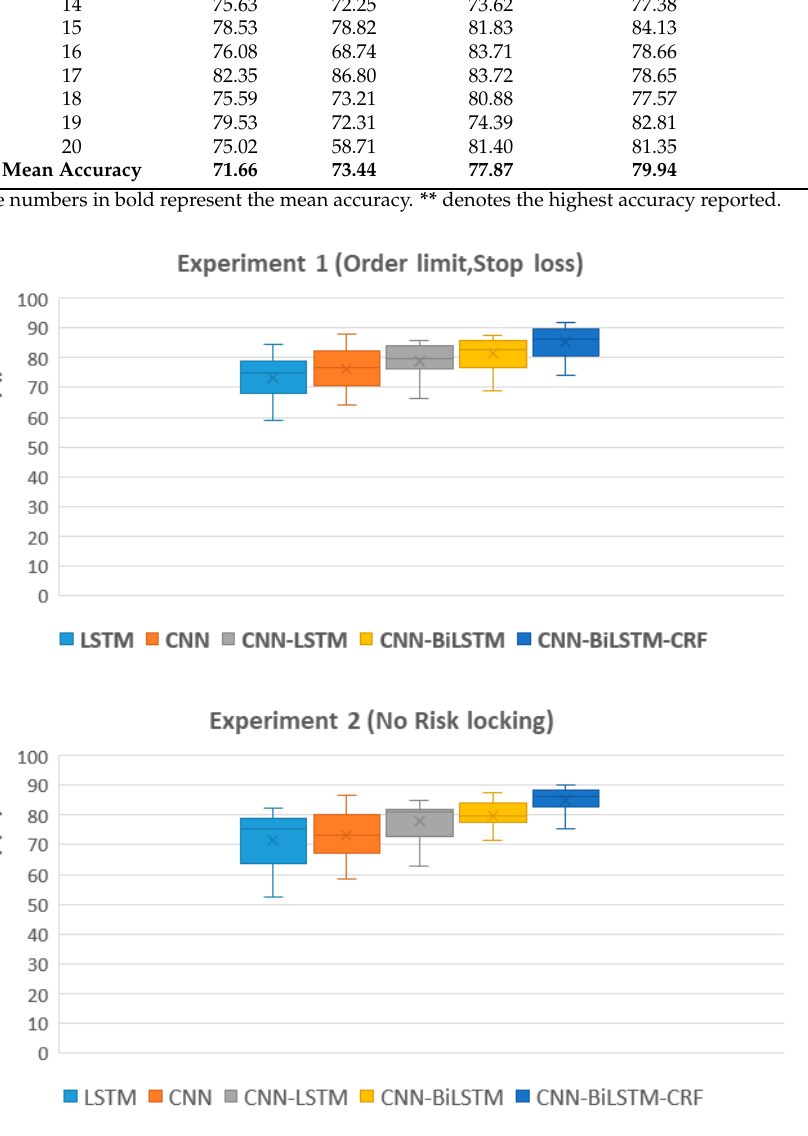
Figure 8. Comparison of the mean classification accuracy across different models for Experiment 1 with risk locking and Experiment 2 without risk locking, as determined by a 10-fold cross-validation technique.